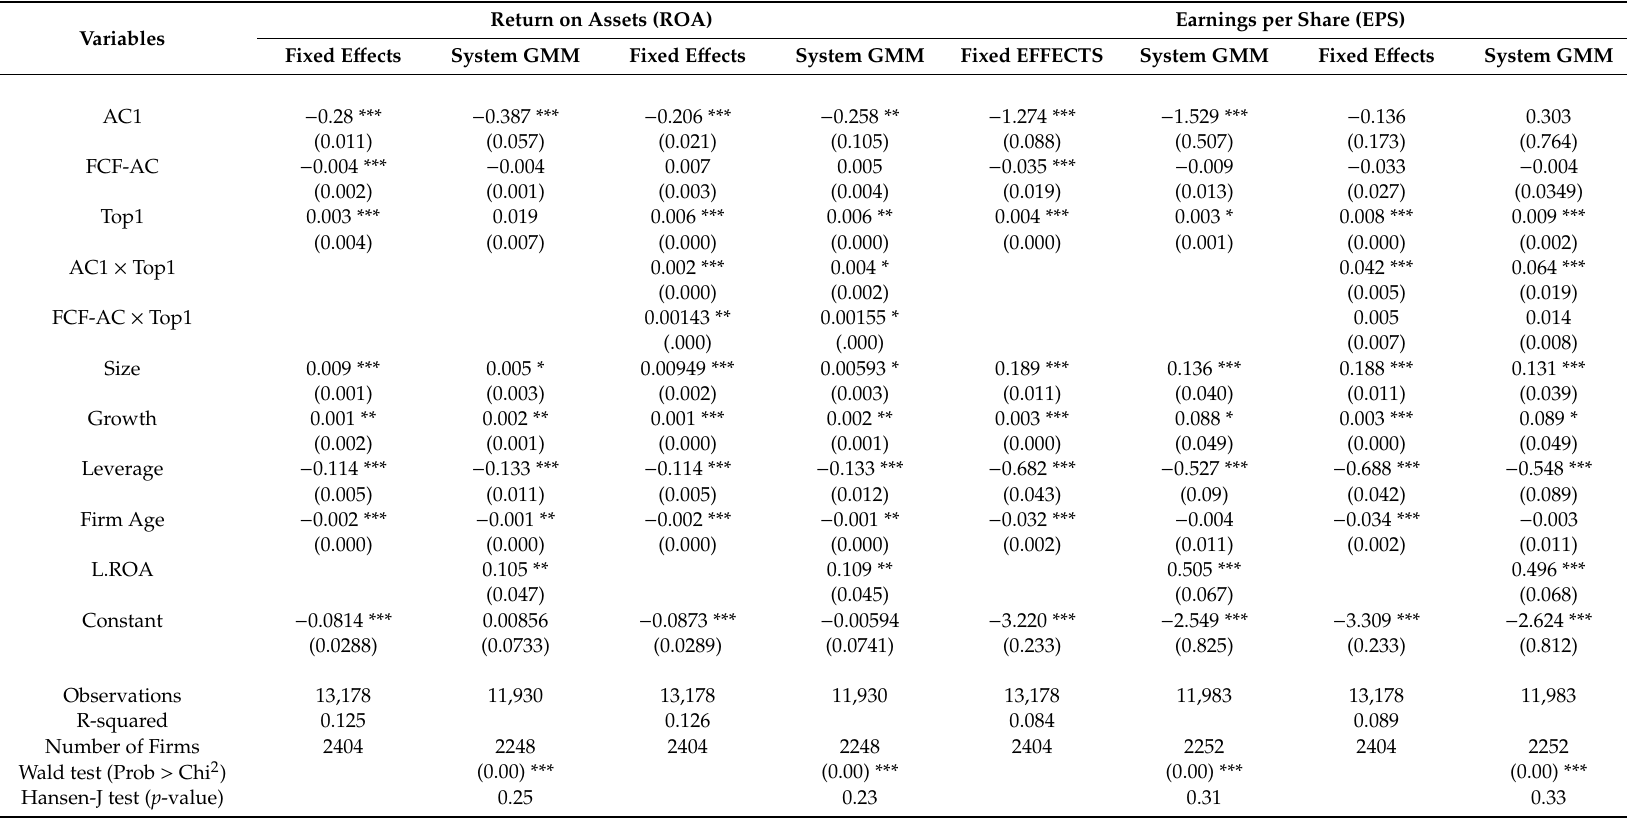
Table 7. Moderating e ff ect of ownership concentration on agency costs and firm